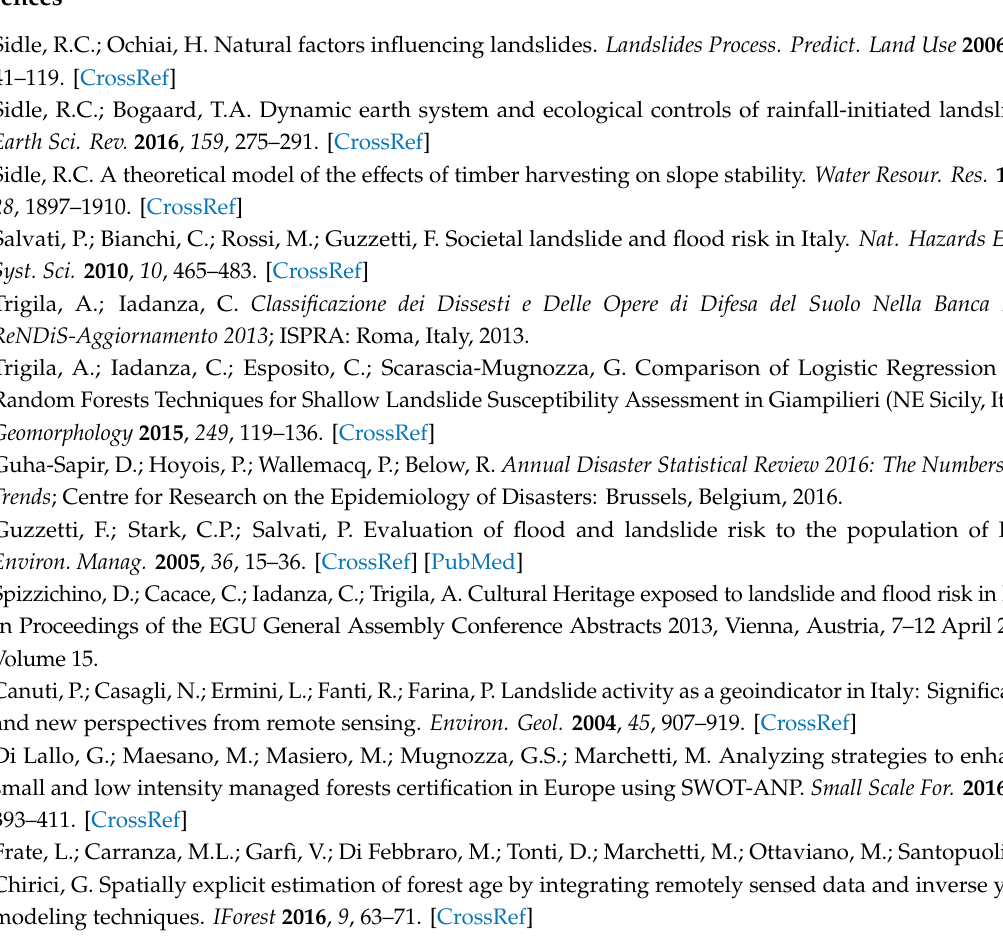
Figure A7. Groundwater table of the study Figure S7. Groundwater table of the study area